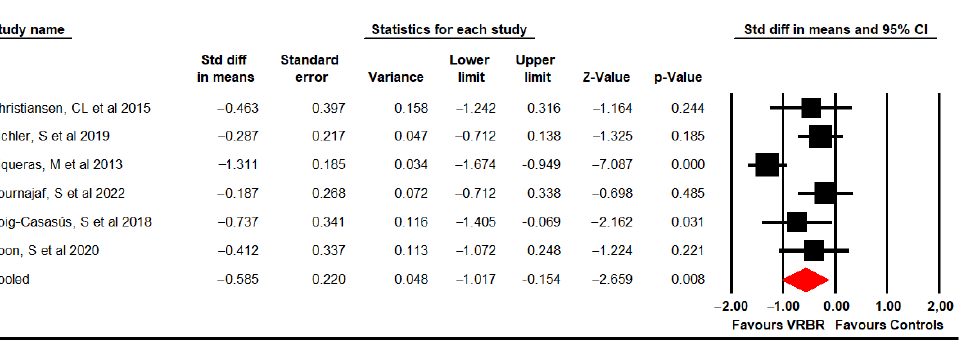
Figure 4. Forest plot of the immediate effect of VRBR on dynamic balance